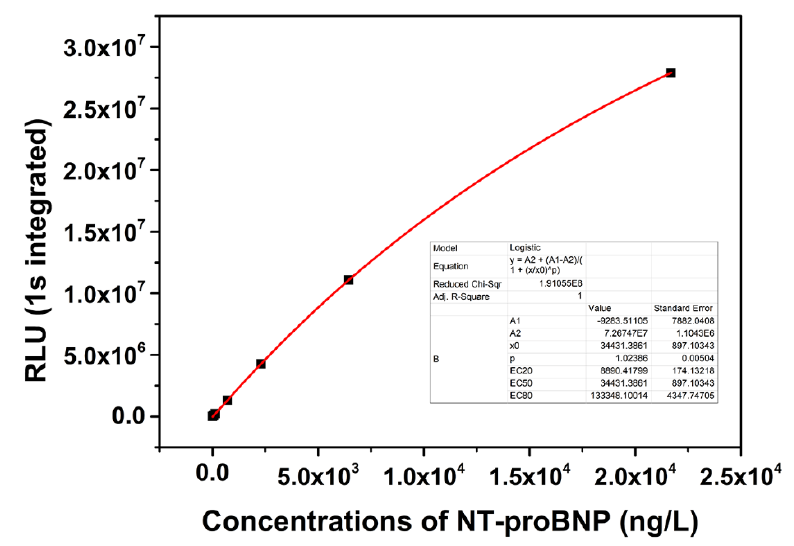
Figure 4. The relationship between chemiluminescence values and NT-proBNP concentrations by four parameter logistic curve fitting.